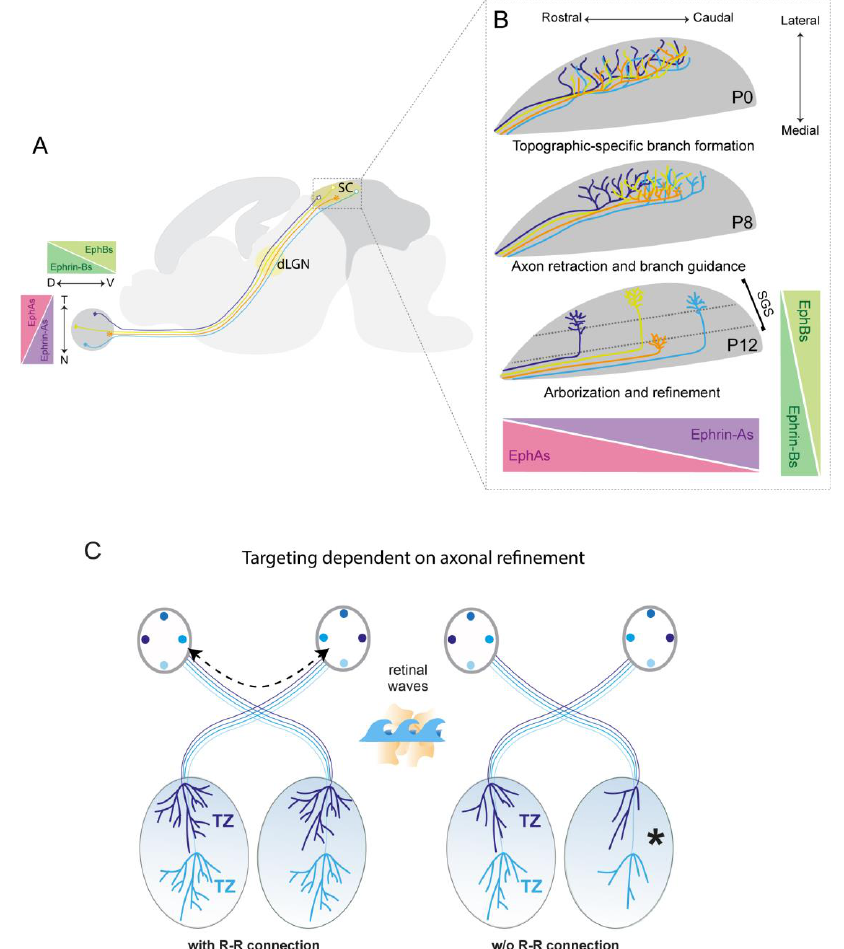
Figure 3. Establishment of RGC axon organisation in the mouse superior colliculus. ( A ) RGC